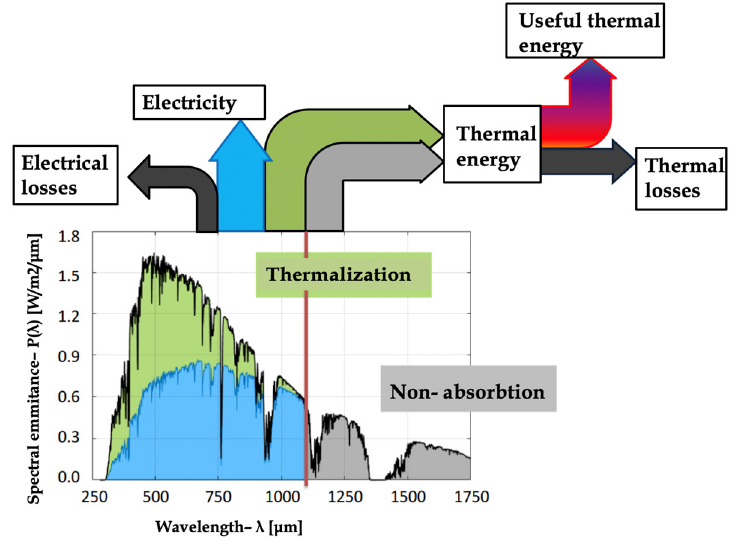
Figure 2. Energy flux in a PVT panel.